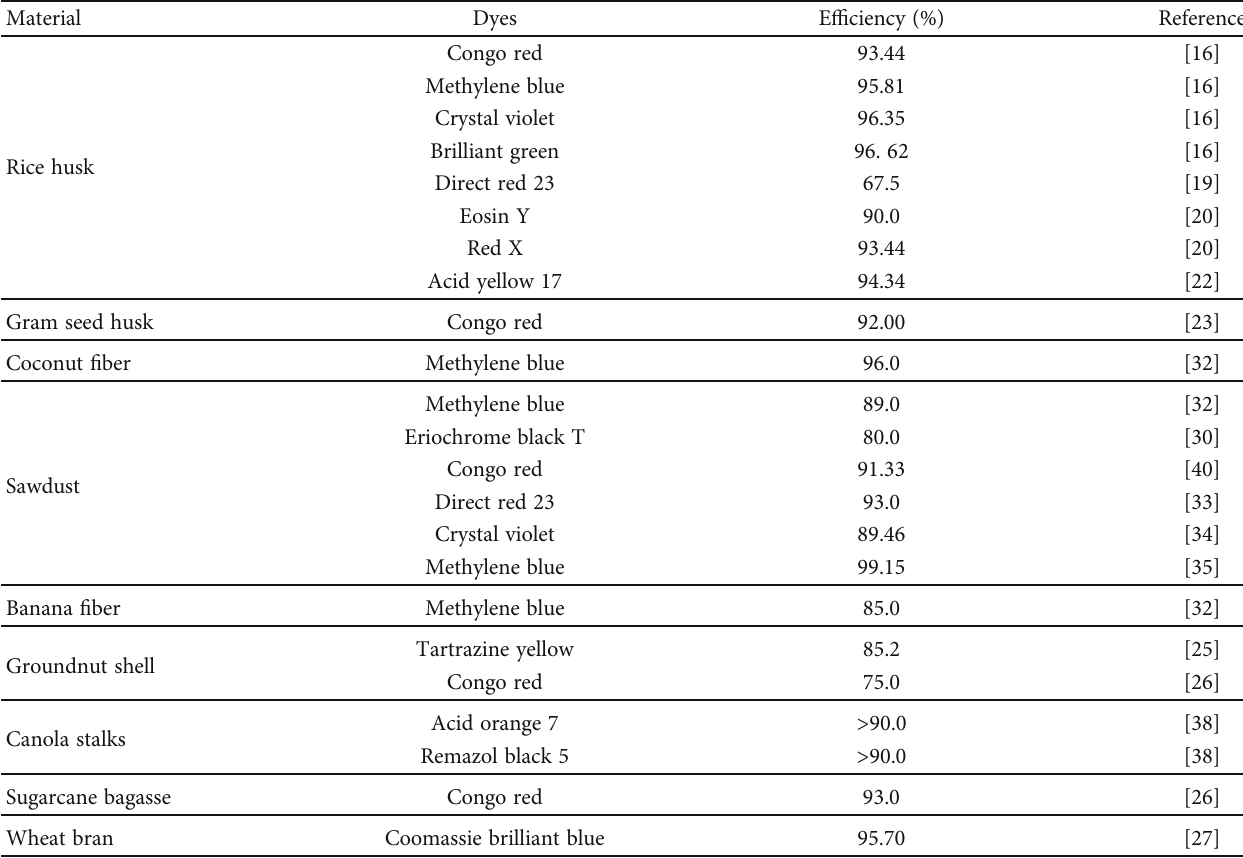
Table 2: Reported removal e ffi ciencies (%) of various biomass-derived adsorbents for the removal of di ff erent dyes.